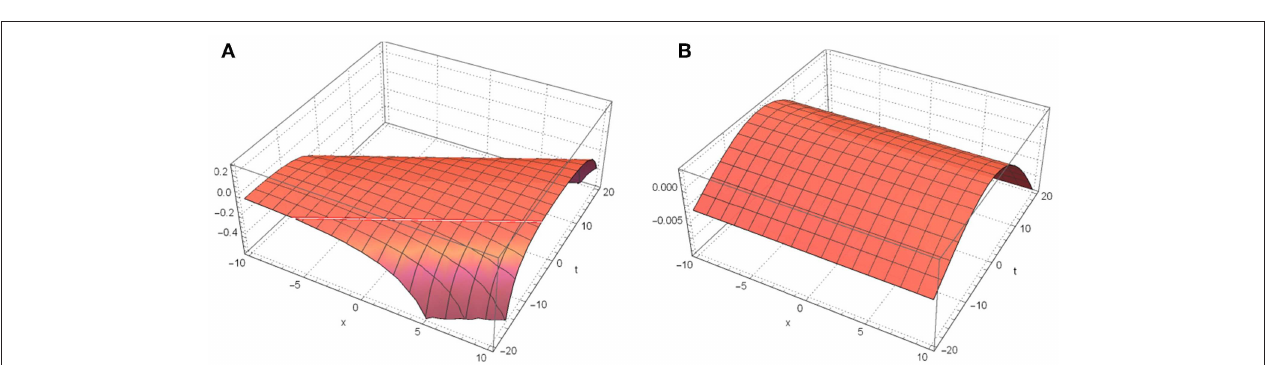
1.2, k 3 2, k 4 2. (A) u 5 ( x , t ). (B) u 8 ( x , t ). = = = −